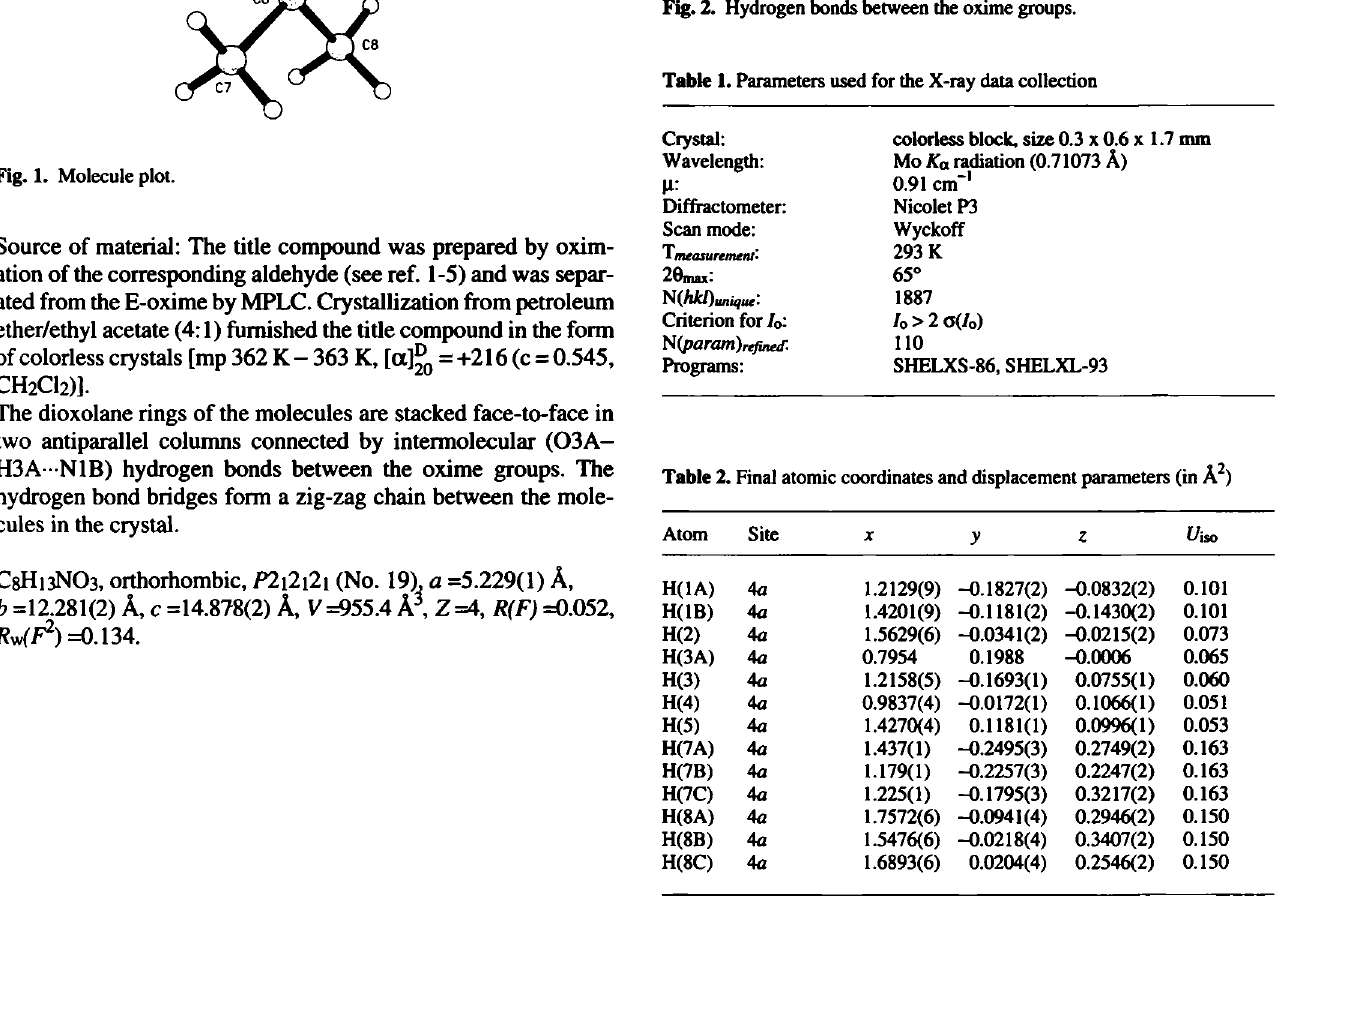
Fig. 2. Hydrogen bonds between the oxime groups.